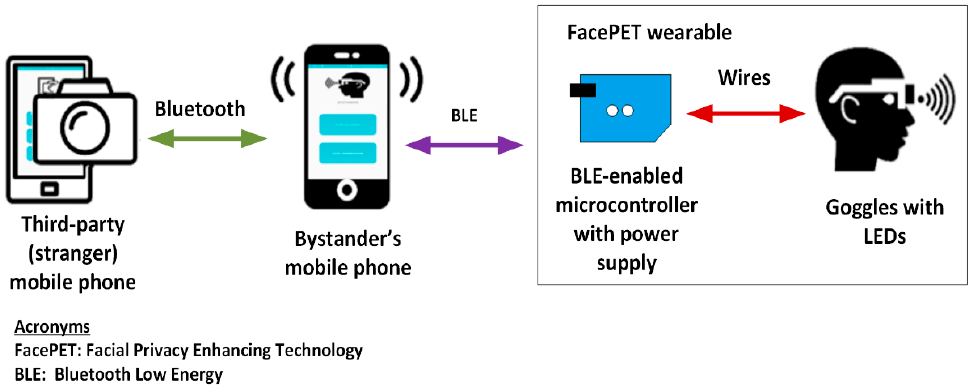
Figure 5. FacePET system’s hardware architecture.